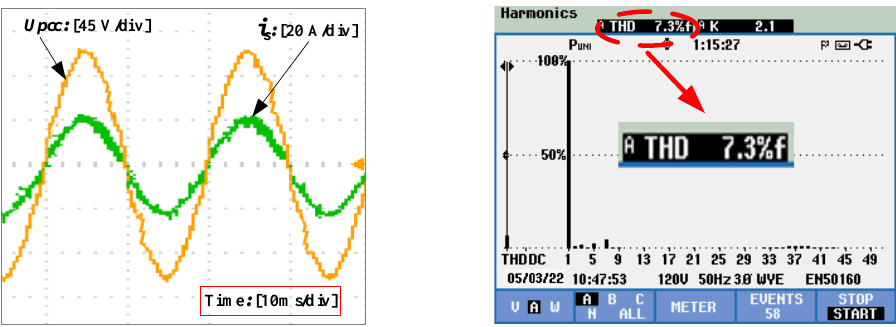
Figure 12. Waveform of U PCC , i s and the THD of the grid current under PLL control with Z g = 1.8 mH.